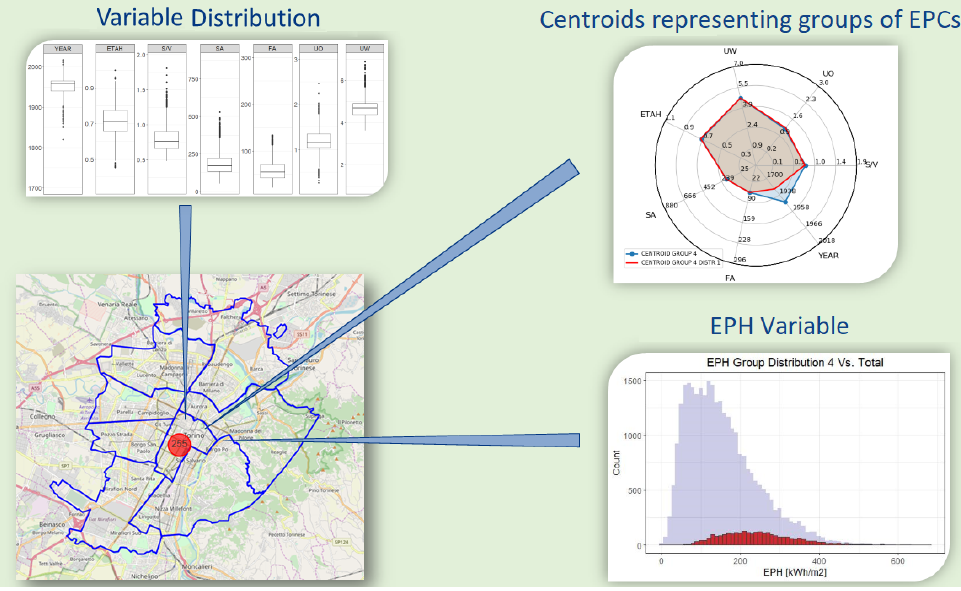
Figure 12. Example of statistics for a